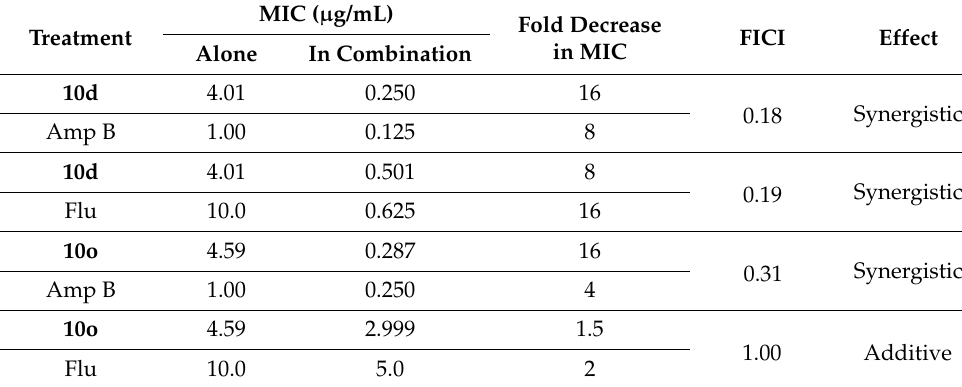
Table 5. Evaluation of combinative effect of bioactive peptides with amphotericin B (Amp B) and fluconazole